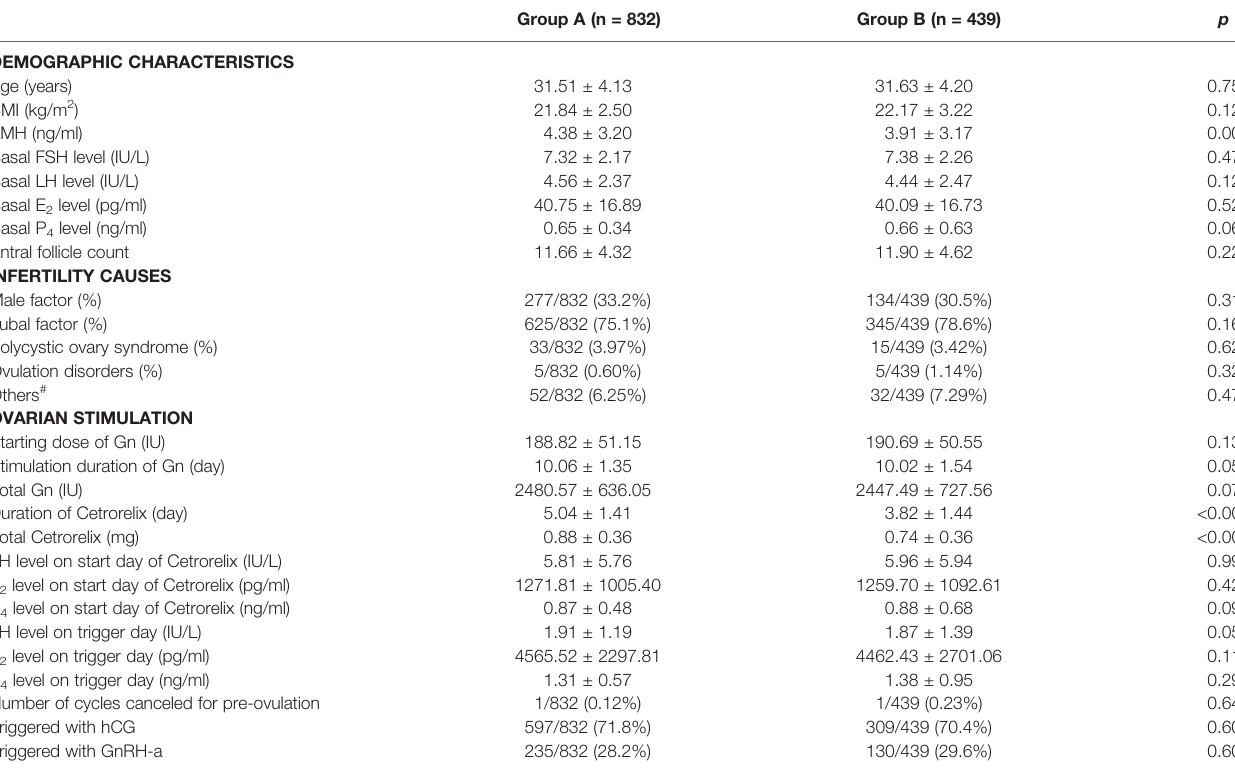
TABLE 1 | Demographic and clinical characteristics of the study